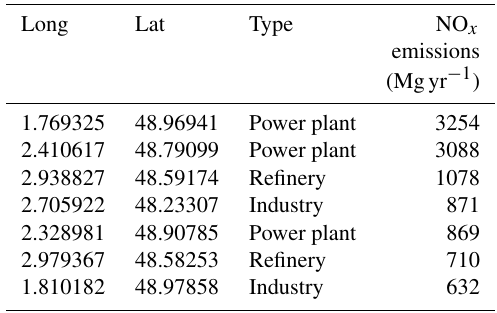
Table 1. Location and type of major point sources in the domain of study. Long